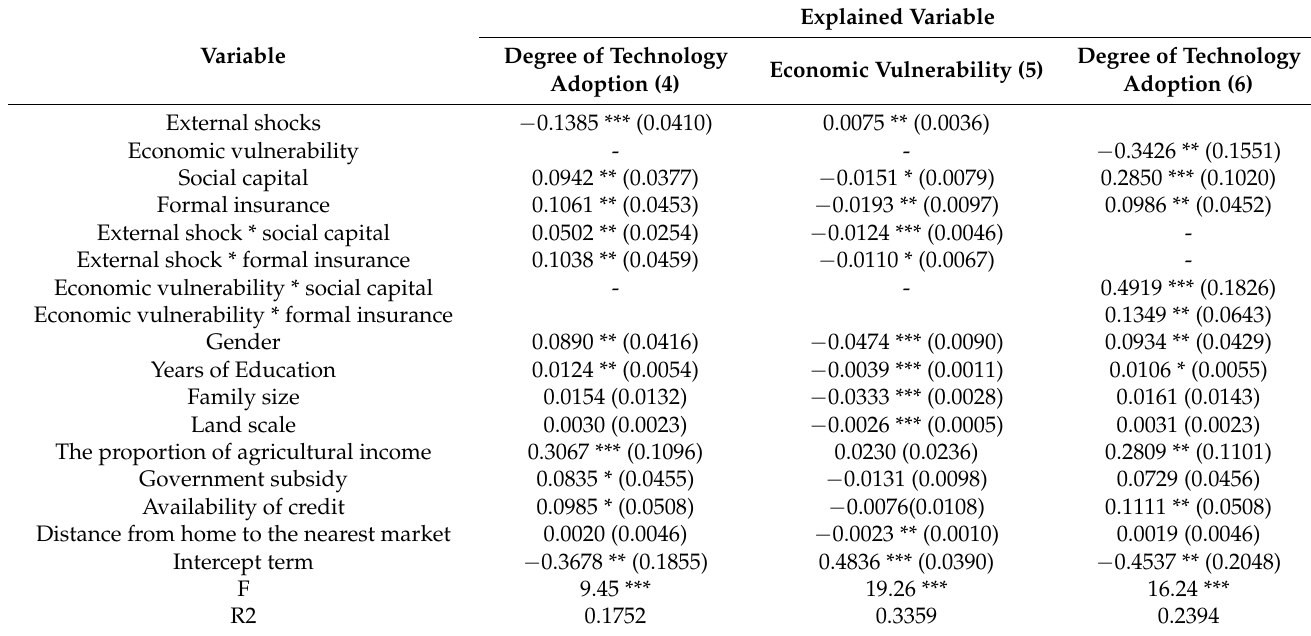
Table 2. Regression results of the moderator effect of risk-taking